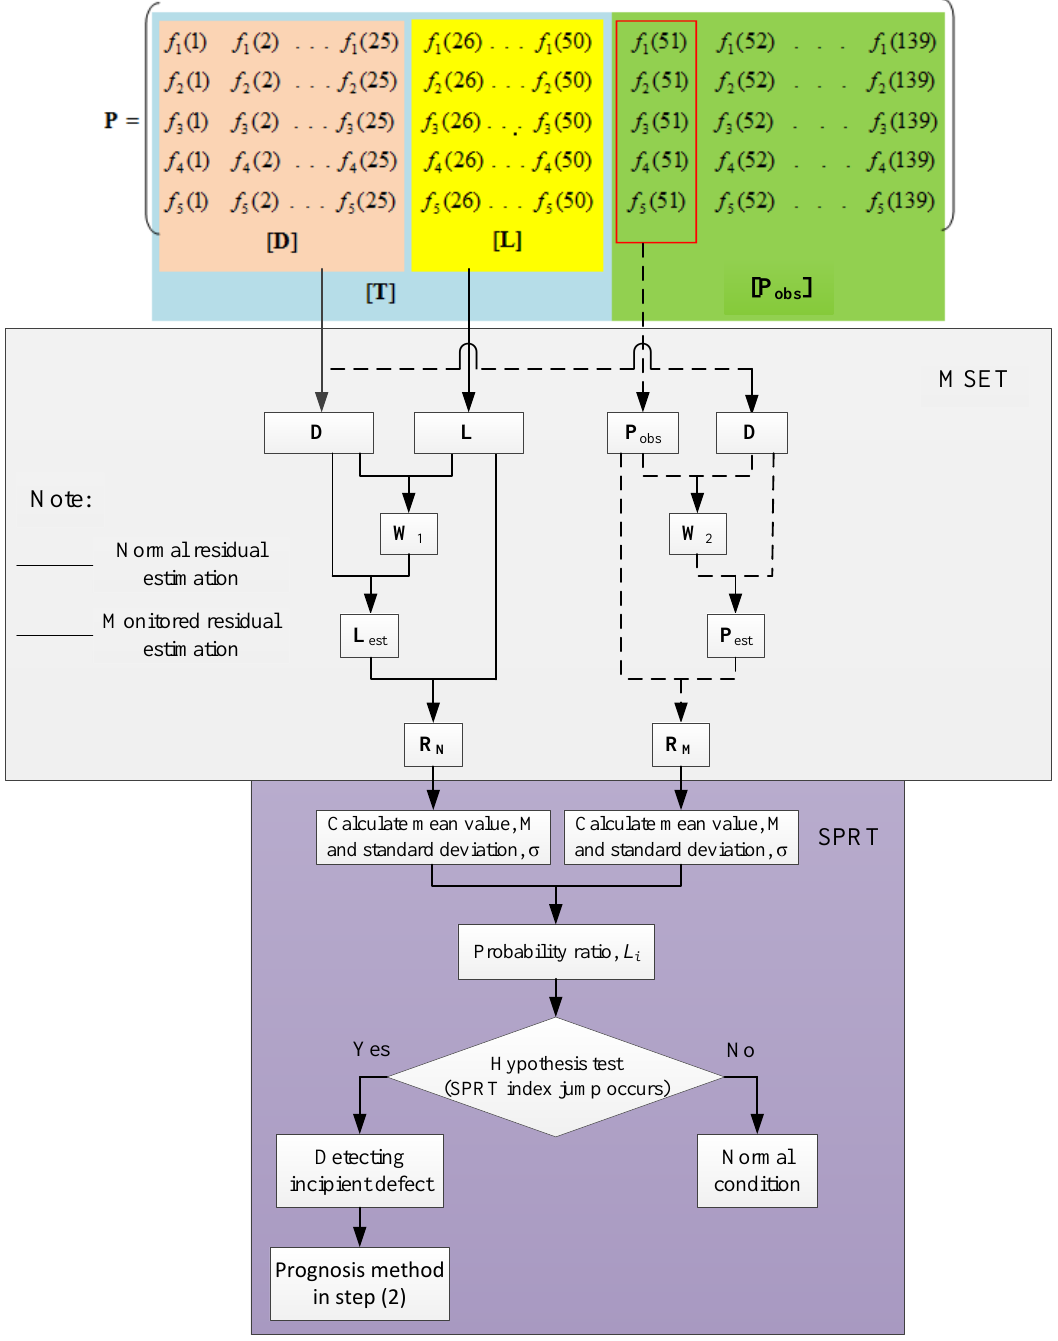
Figure 3. Flowchart of the proposed combined MSET and SPRT method in step